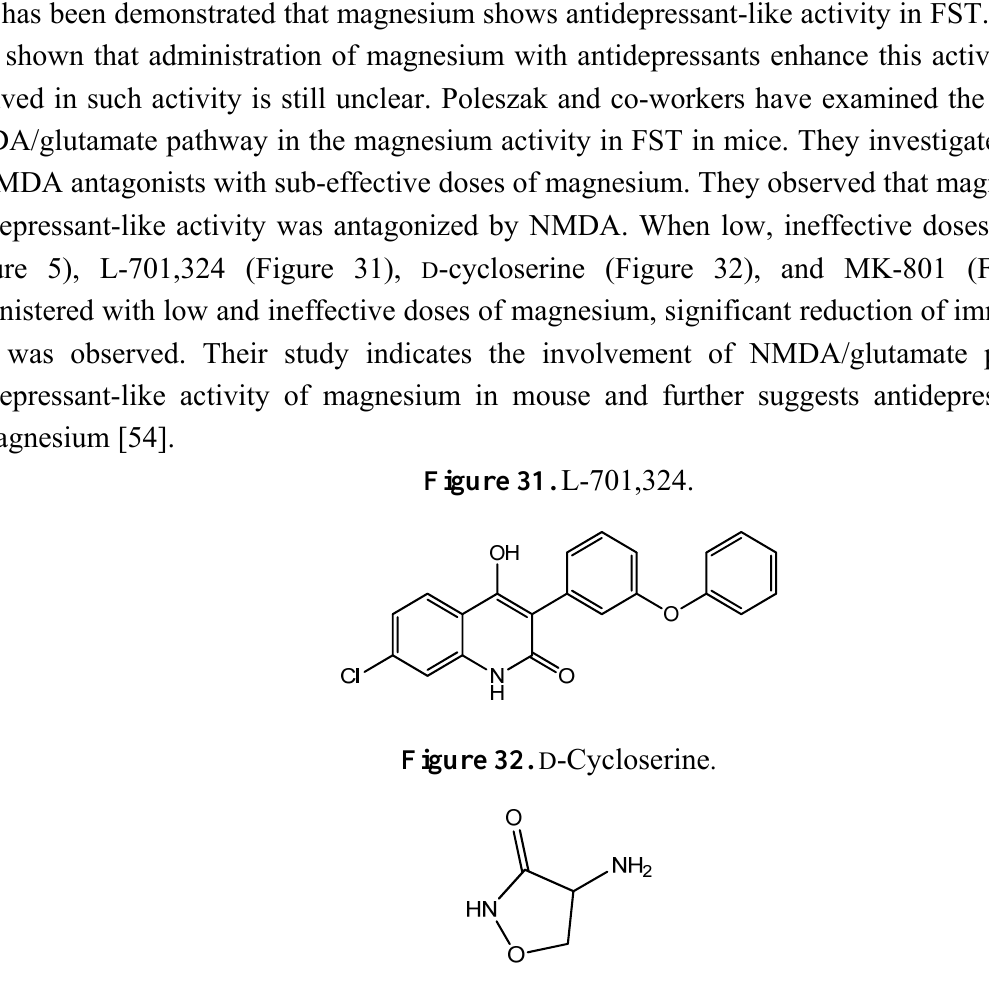
Figure 32. D -Cycloserine